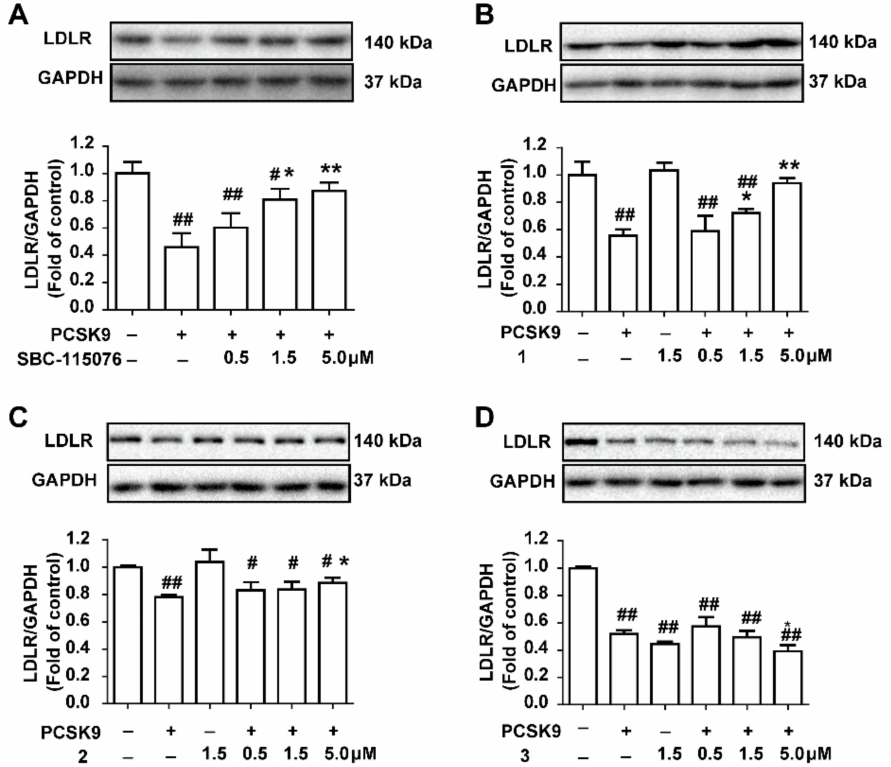
Figure 5. The activities of compounds 1 – 3 on preventing PCSK9-mediated LDLR degradation in the HepG2